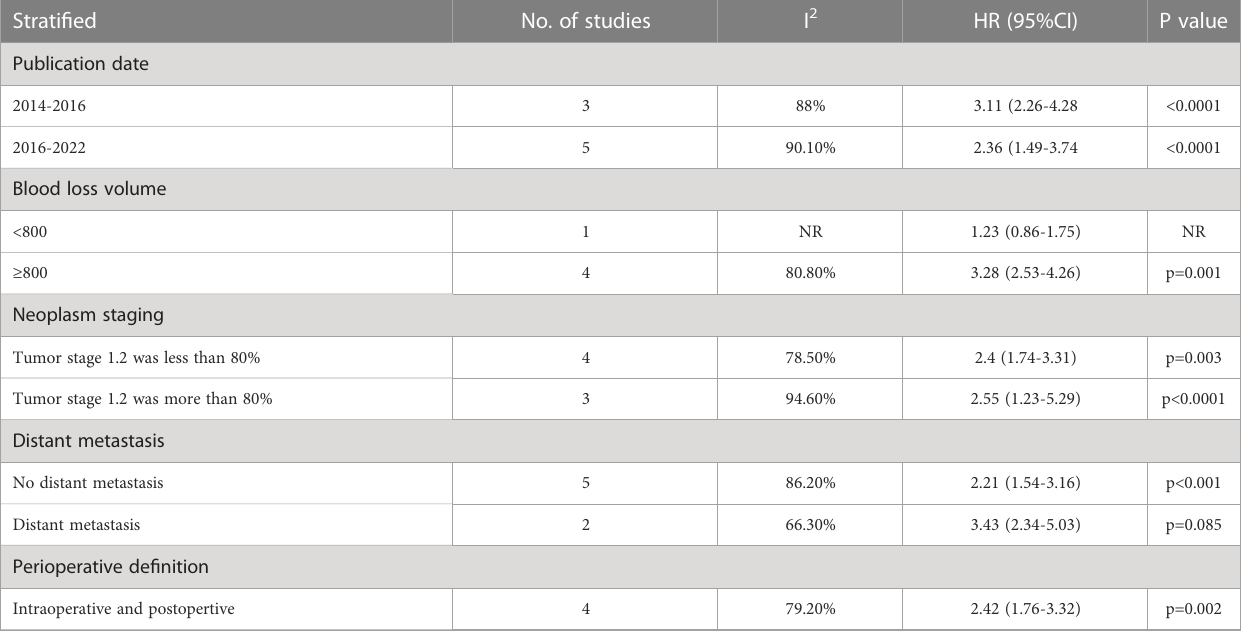
TABLE 3 Subgroup analysis of overall